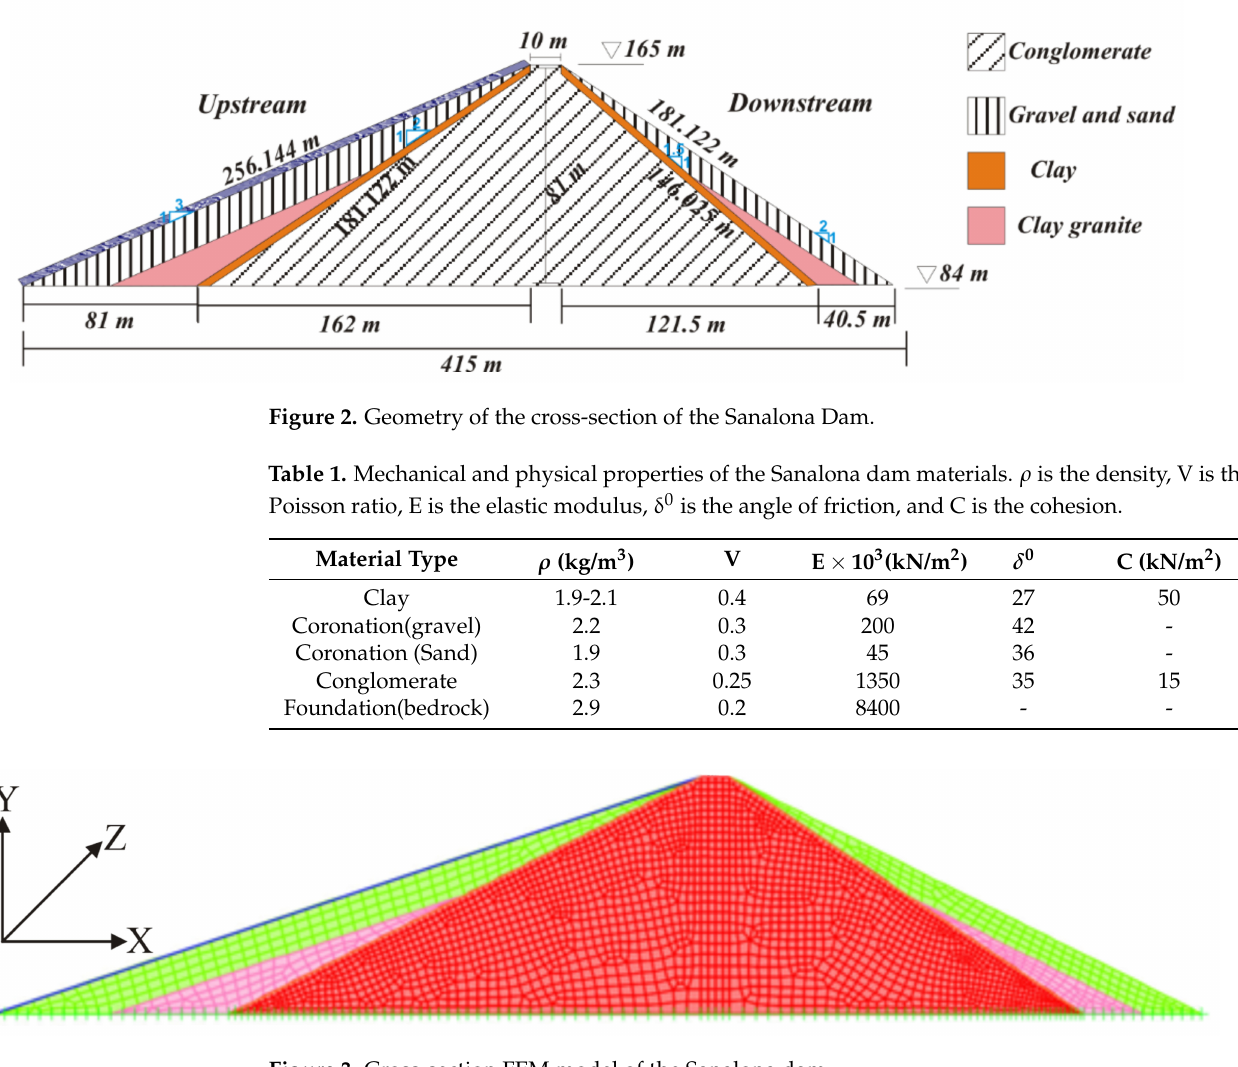
Figure 3. Cross-section FEM model of the Sanalona